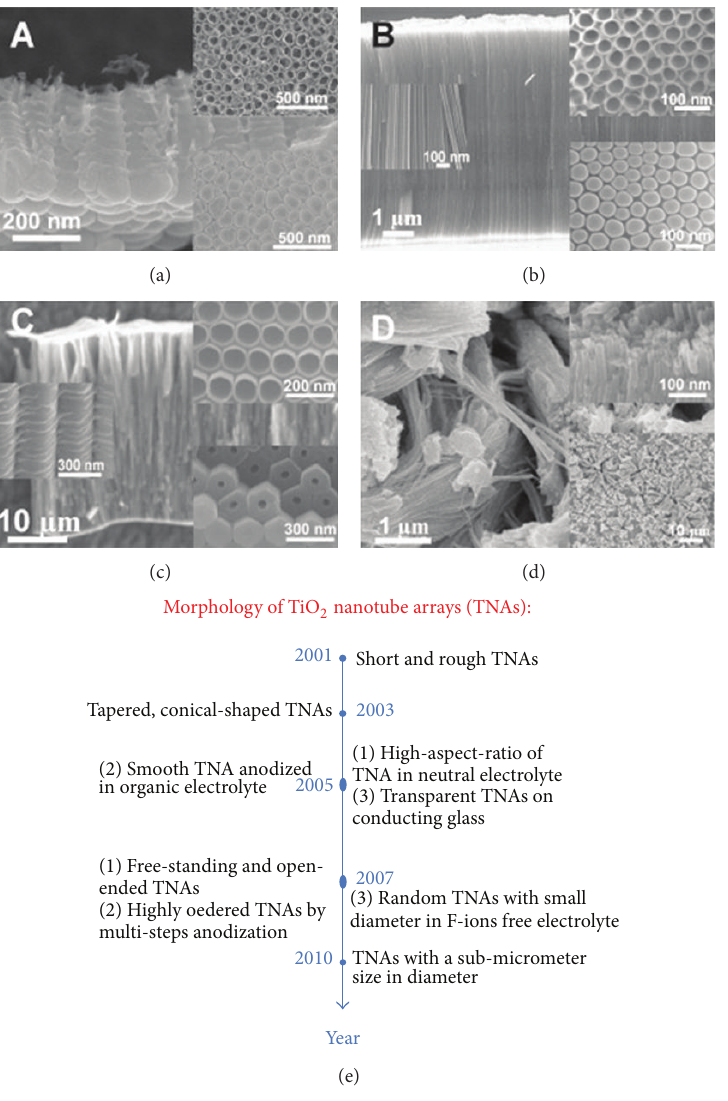
Figure 1: SEM images of TNA layers grown with different electrolytes. (a) Typical morphology obtained in acidic fluoride or HF electrolytes, (b) glycerol/fluoride electrolytes, and (c) ethylene glycol/fluoride electrolytes containing small amount of water. The insets show top views, bottom views, and side walls in detail. (d) Fluoride ions free electrolyte; these tubes grow in disordered bundles within seconds at comparably high anodic potentials. (e) Morphology of new type TNAs with